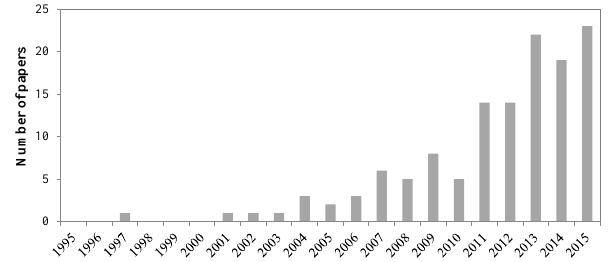
Figure 1. Number of MCDM flood papers published over the period 1995–June